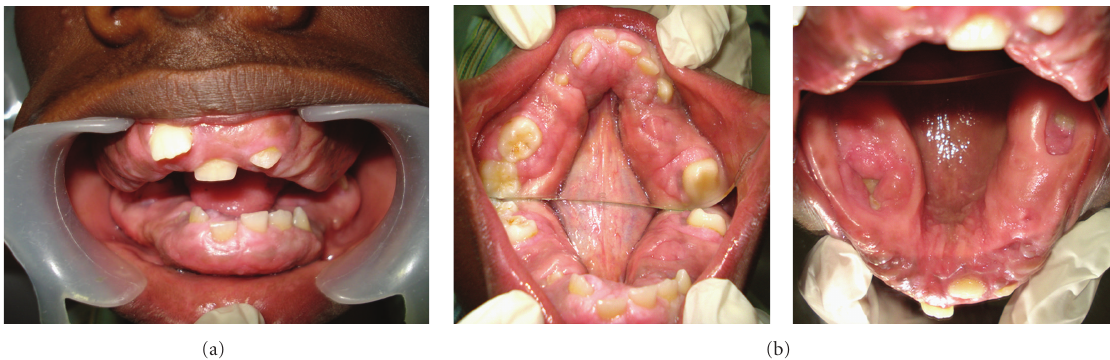
Figure 2: (a) Preoperative intraoral front view. (b) Preoperative mirror image of lower arch and upper arch